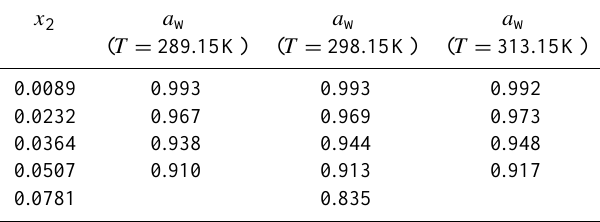
Table A7. Bulk water activity (a w ) measurements a of water (1) + raffinose (2) solutions at three different temperatures. Solution composi- tions are given in mole fraction of the organic component (2), x 2 . x 2